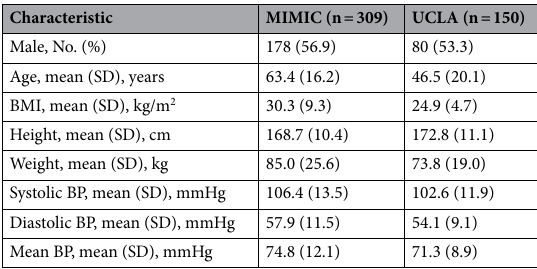
Table 1. Cohort characteristics of MIMIC and UCLA